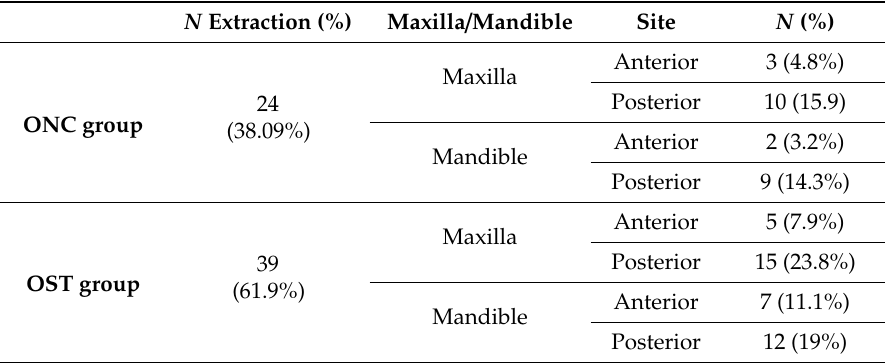
Table 4. Descriptive details of the extracted teeth (total N =